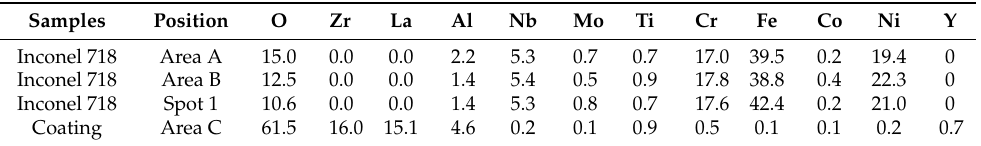
Table 5. EDS results of corroded surfaces of the Inconel 718 substrate and the laser clad speci- men